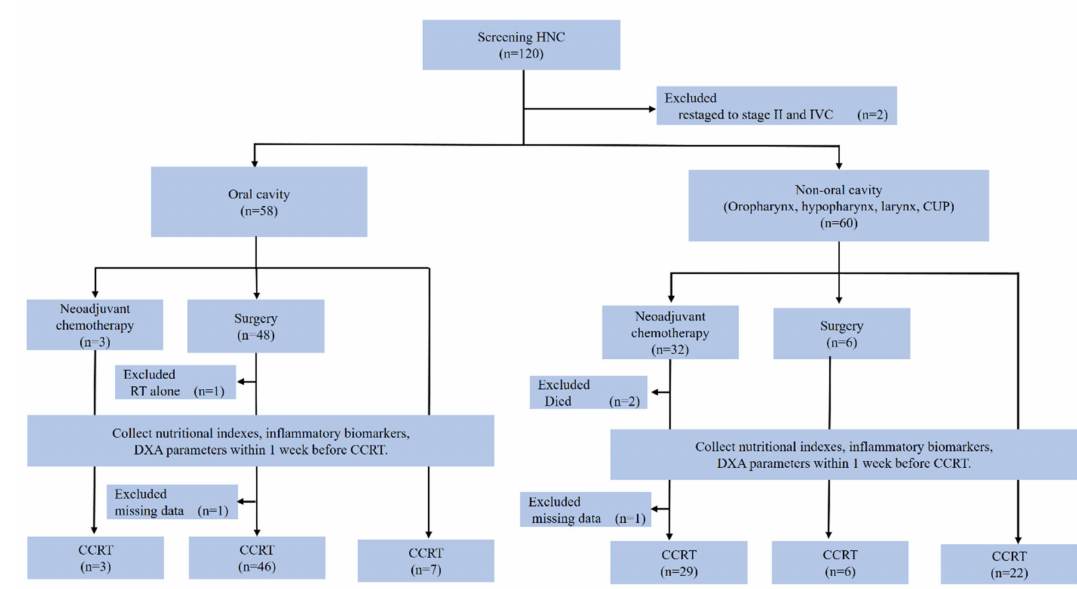
Figure 1. CONSORT diagram. Patients were considered to have completed planned therapy if they received at least four cycles of weekly cisplatin at 40 mg / m 2 concomitants with radiotherapy (64–72 Gy). Incomplete data indicated patients who did not complete the DXA examination or missed blood tests. HNC, head and neck cancer; CUP, cancer of unknown primary; RT, radiotherapy; DXA, dual-energy X-ray absorptiometry; CCRT, concurrent